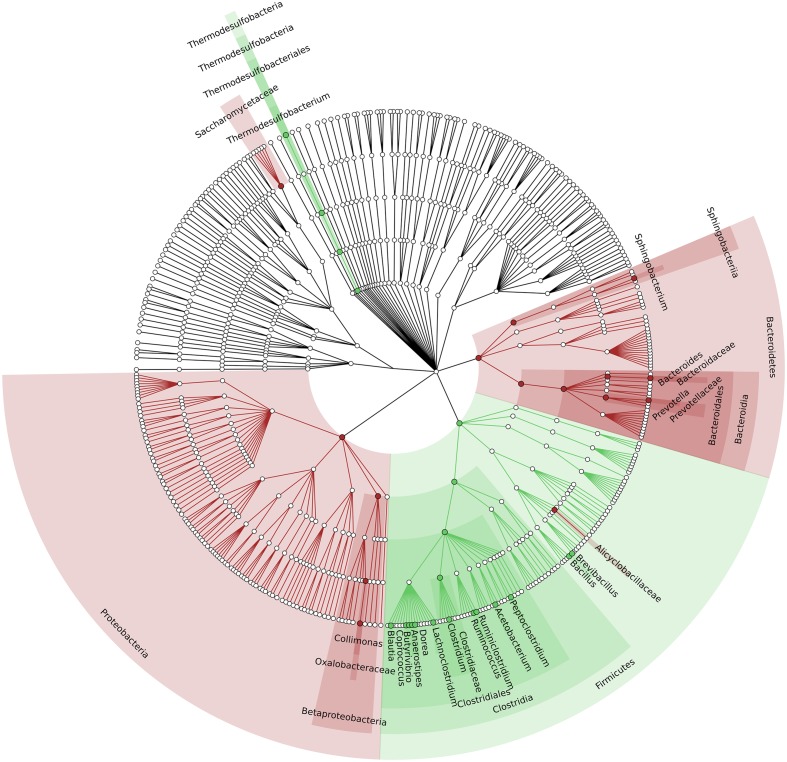
Cladogram illustrating the distribution of taxa with differential abundance between CCs and feces, according to MP data. Each dot represents an identified taxon, with taxa higher in CCs colored in green, and those higher in feces in brown.